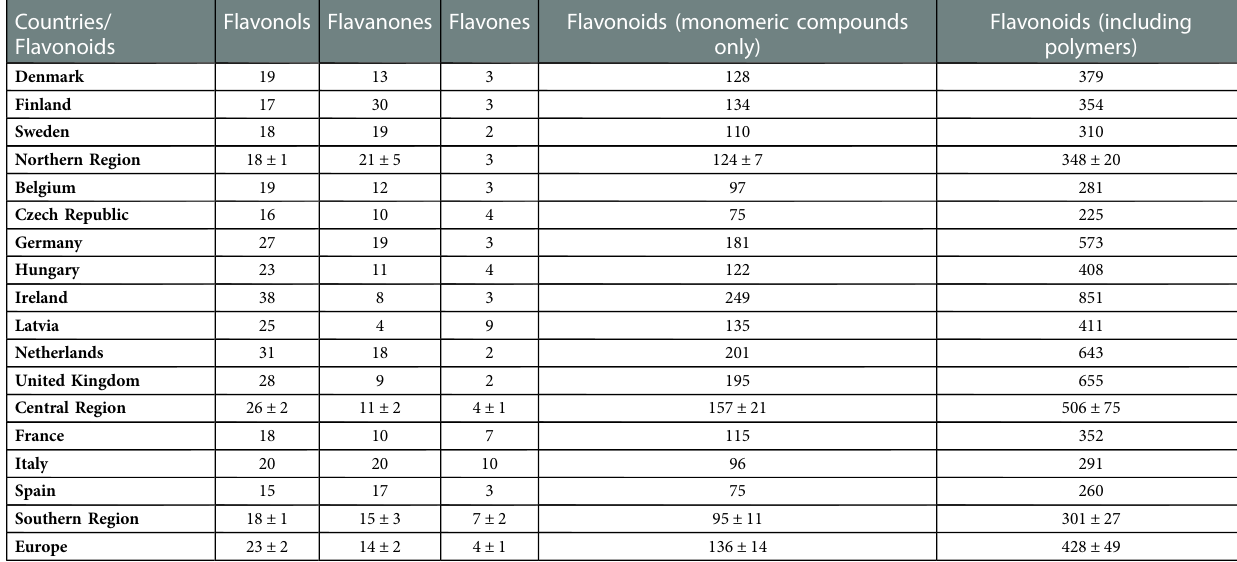
TABLE 1 Daily intake (mg) of fl avonoids in adults in the European union (16). Countries/ Flavonols Flavanones Flavonoids